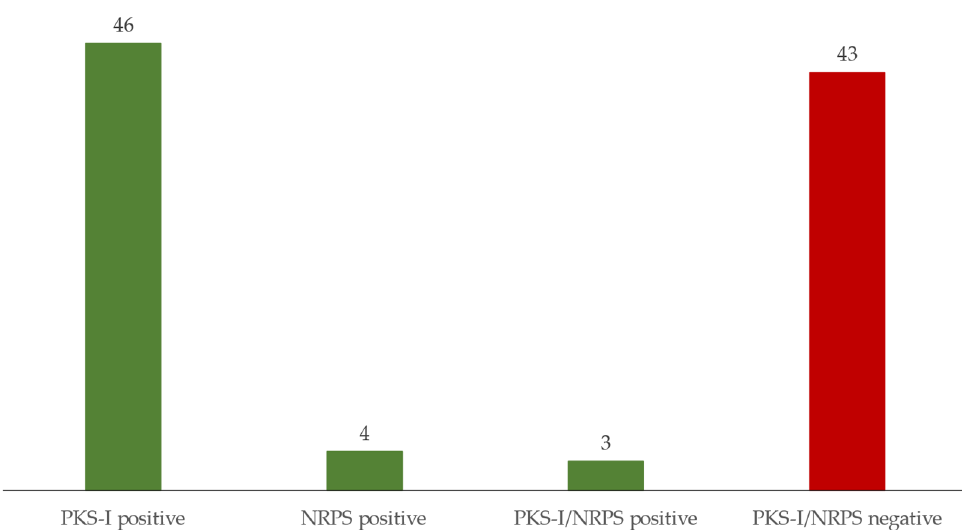
Figure 3. Number of isolated Actinomycetota strains putatively presenting PKS-I and NRPS genes.